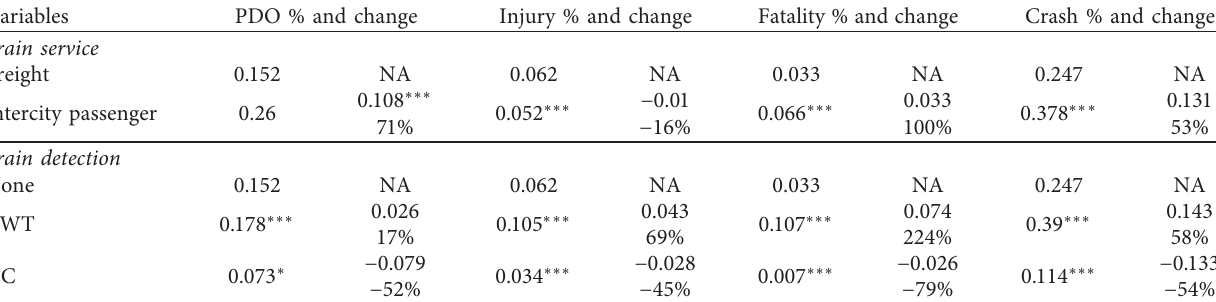
Table 4: Annual average crash probability increasing percentages for train service and detection system.